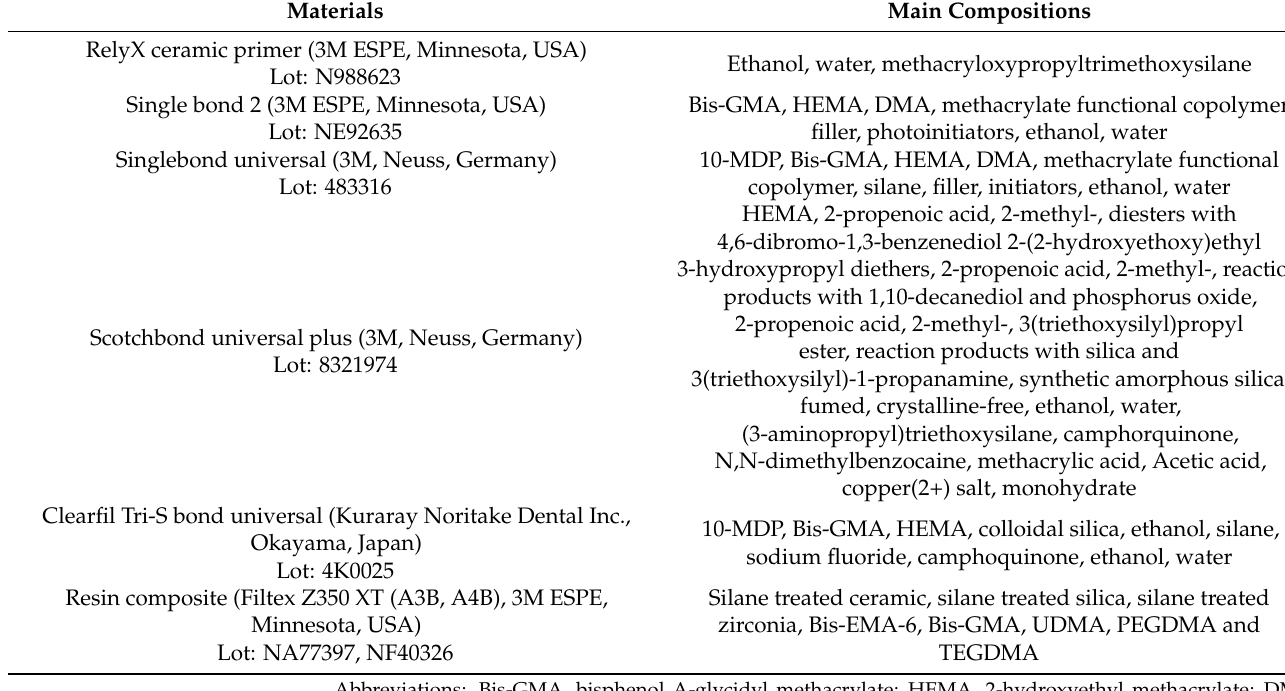
Table 1. Materials used in the